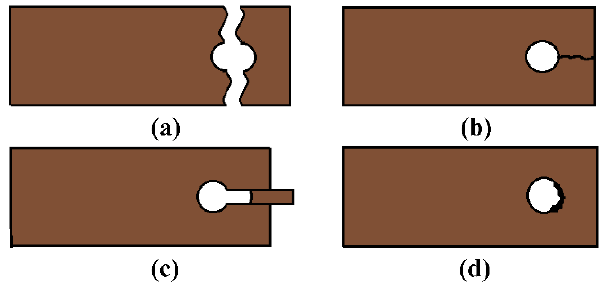
Figure 1. Common in-plane failure modes of bolt joint structures: ( a ) tensile failure, ( b ) splitting failure, ( c ) shear failure, and ( d ) extrusion failure.